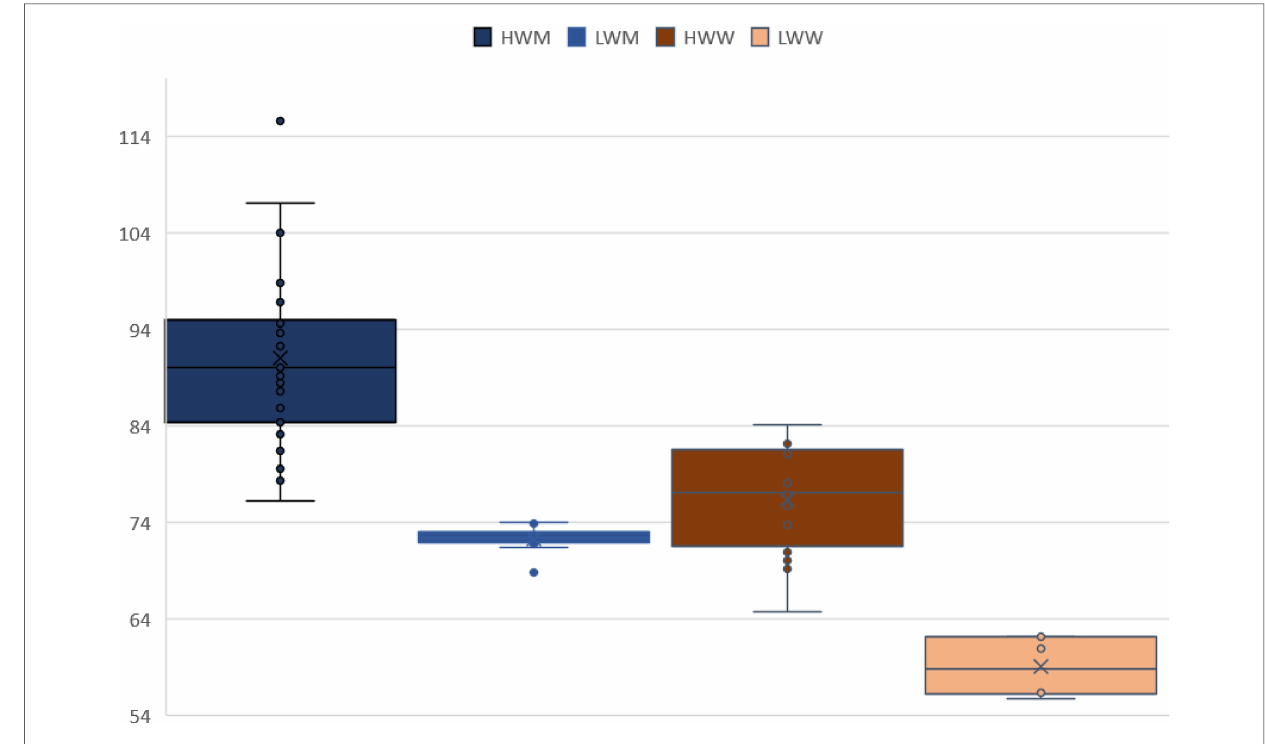
FIGURE 6 Differences in body weight in male and female